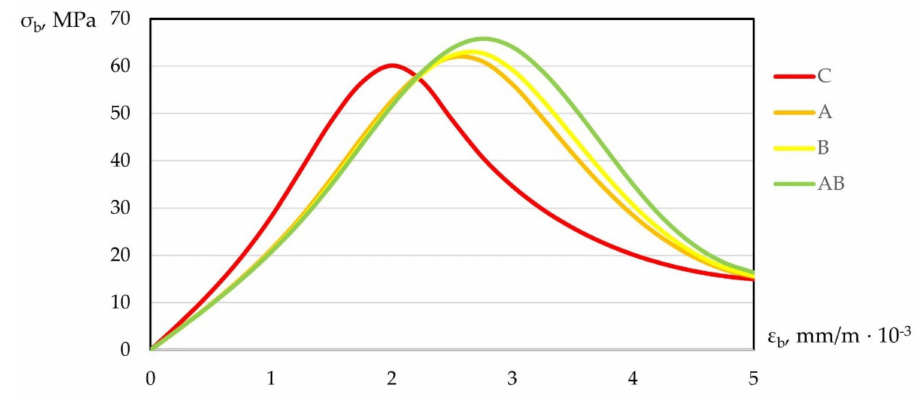
Figure 11. Diagram of “stress–strain” under compression.